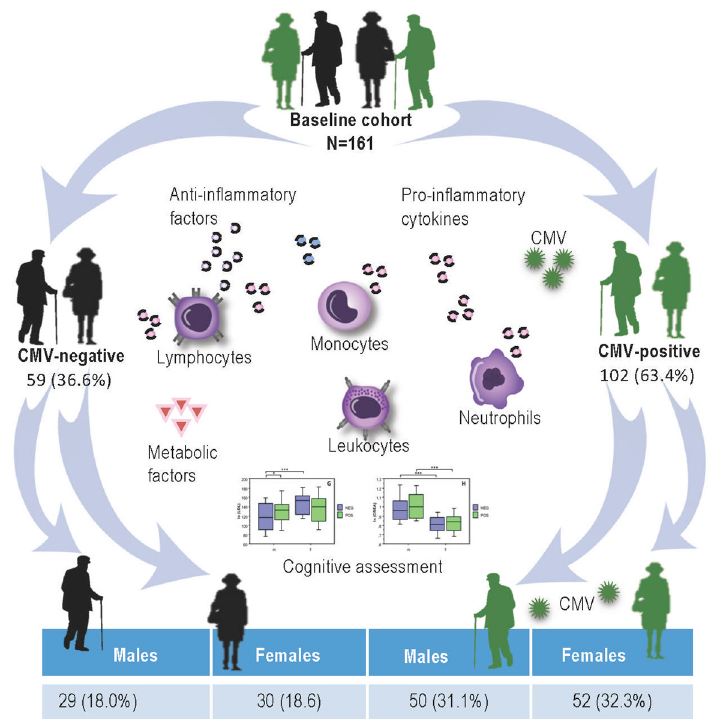
Figure 1. A schematic illustration of the study setup and Cytomegalovirus (CMV)-serostatus of study participants. CMV: Cytomegalovirus.